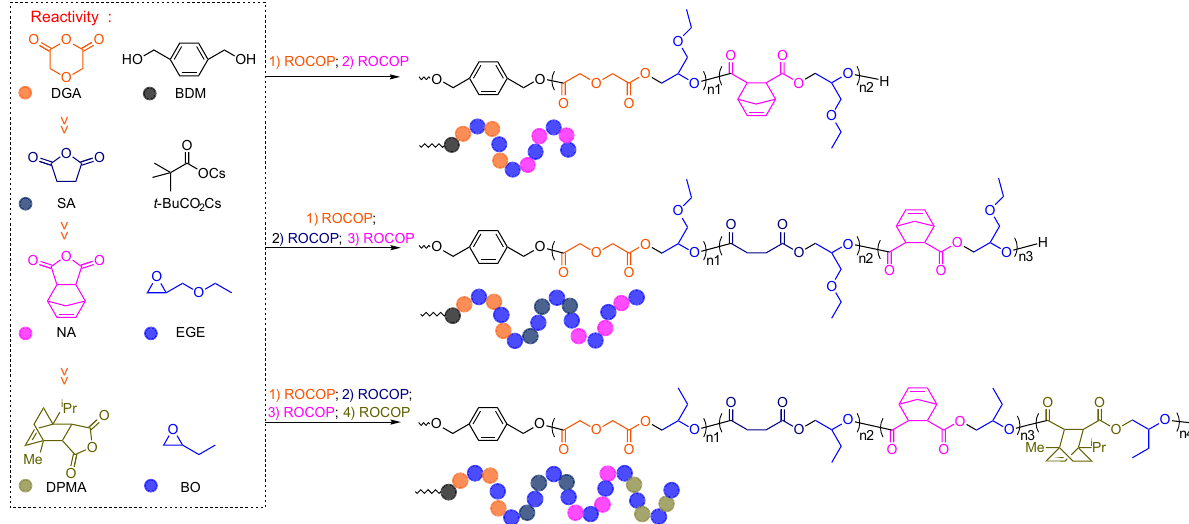
Fig. 3 The synthesis of multiblock polymers with various sequences by the combination among different anhydride/epoxide ROCOP at 100 °C. Orange: DGA. Pink: NA. Dark blue: SA. Blue: EGE or BO. Olive: